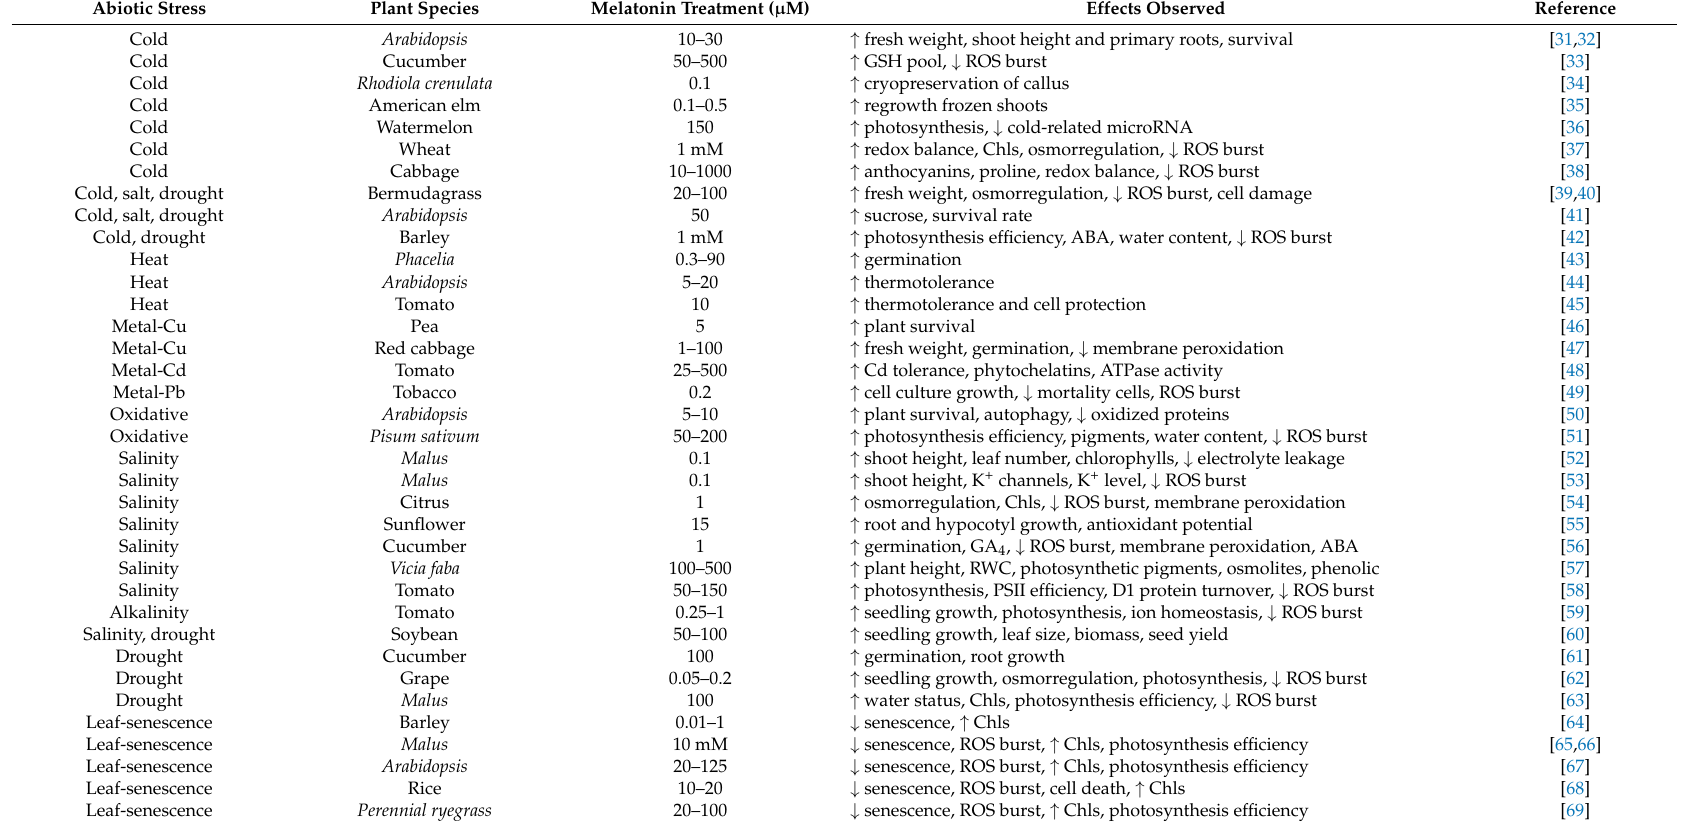
Table 2. Effects of melatonin in abiotic stress